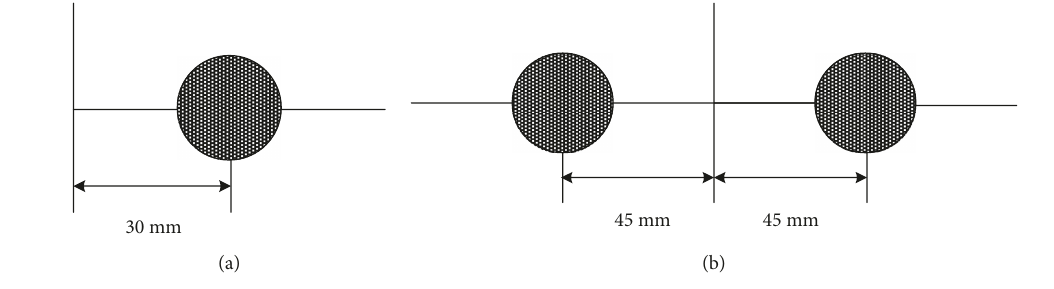
Figure 2: Actual pro fi le of the experiments: (a) dielTM; (b) twodielTM. Table 1: Proportion of nonzero elements in matrix L z